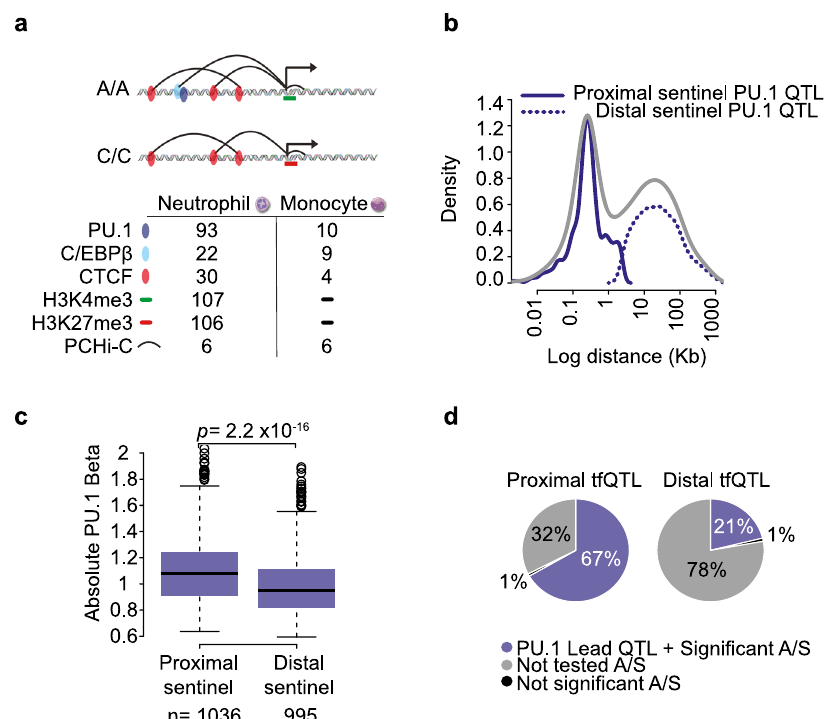
Fig. 1 Properties PU.1 transcription factor QTLs. a Summary of molecular traits generated as part of this study. b Density plot displaying the distance between sentinel SNPs and their associated PU.1 peaks. The bimodal distribution (grey) can be further subdivided into proximal (solid navy, <2.5 kb) and distal SNP effects (dotted, >2.5 kb). c Boxplot of absolute PU.1 tfQTL effect sizes (beta). Proximal PU.1 tfQTLs exhibit larger effect sizes compared to distal tfQTLs (Welch two-sided t -test). Box plots show the medians (centre lines) and the 25th and 75th percentiles (box edges), with whiskers extending to 1.5 times the interquartile range. n = the number of PU.1 tfQTL in each category. d Proportion of signi fi cant tfQTL SNPs with signi fi cant allele-speci fi c (A/S) binding. Peaks without suitable heterozygous SNPs were not tested